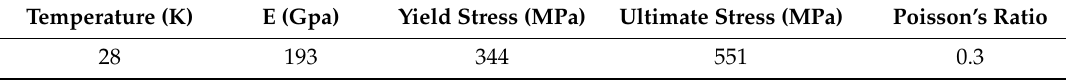
Table 9. Mechanical properties of the electrodeposited